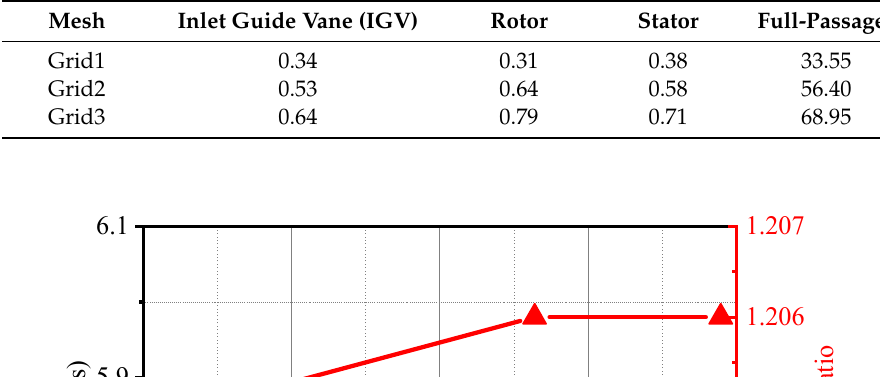
Table 1. Grid number of three sets of grids (×10 6 ).